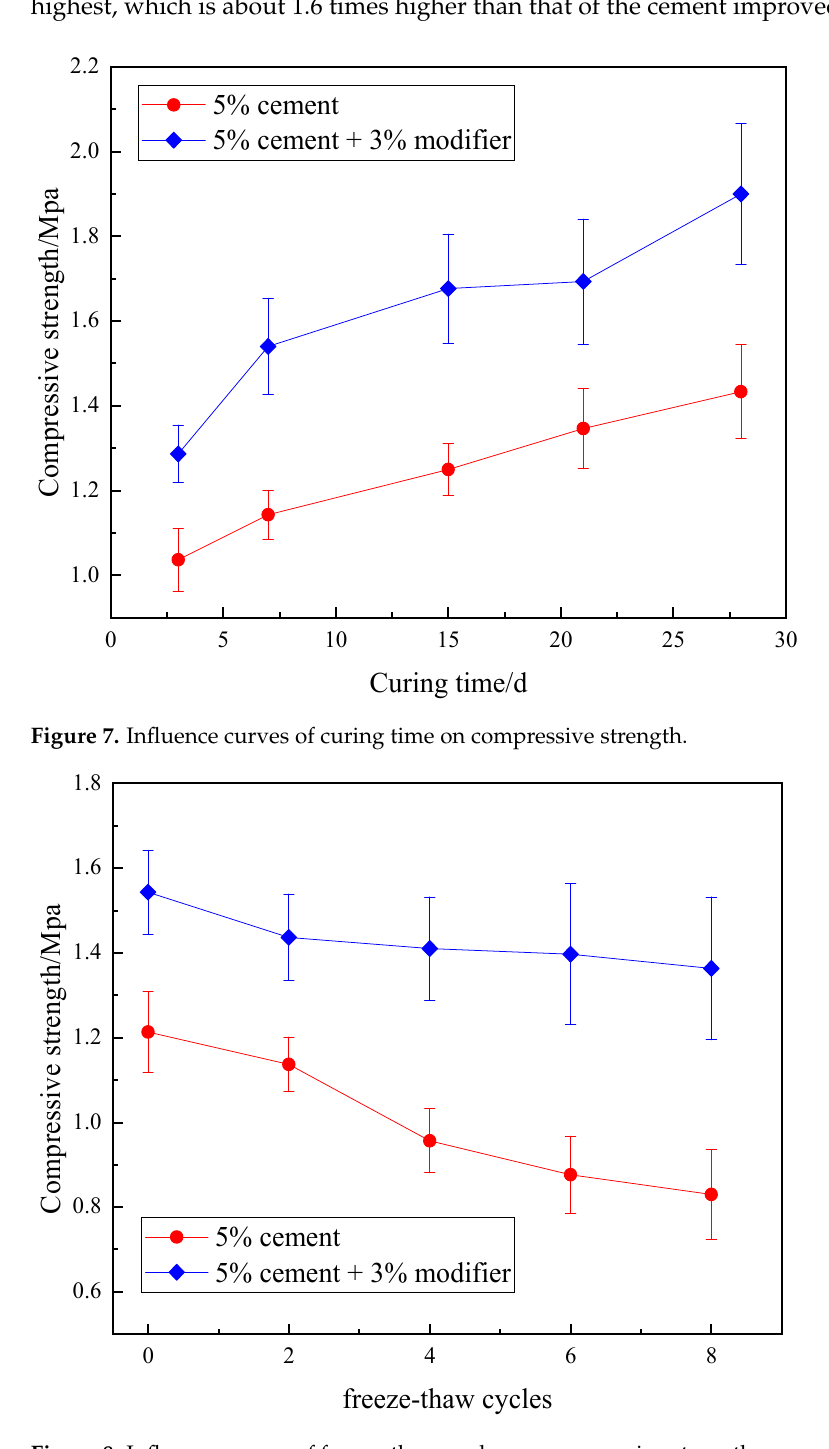
Figure 8. Influence curves of freeze–thaw cycles on compressive strength.